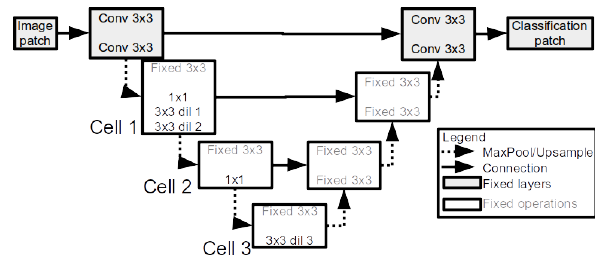
Figure 8. NAS network.